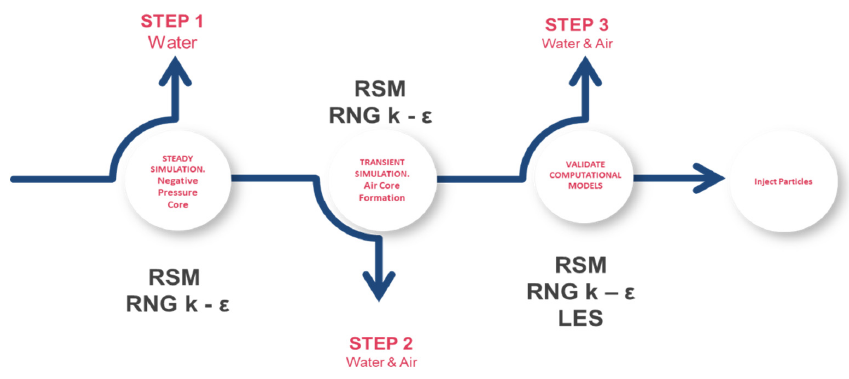
Figure 2. Simulation step for hydrocyclone.